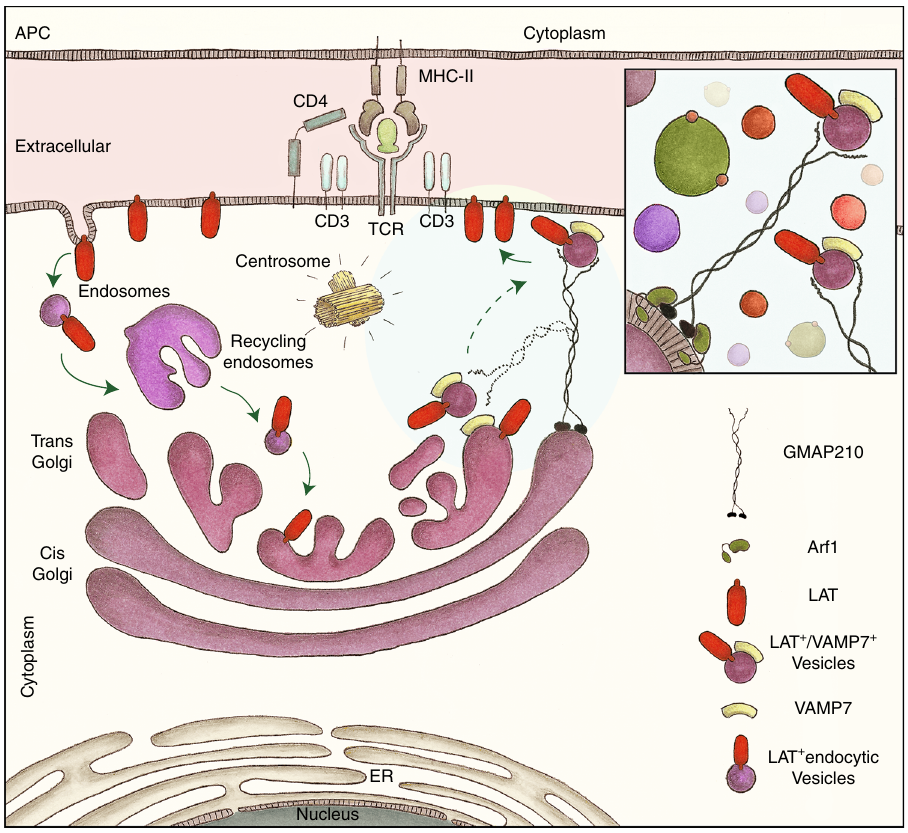
Fig. 9 Graphical abstract: GMAP210 facilitates the delivery of vesicles containing LAT to the immune synapse. Upon TCR triggering, LAT is internalized in recycling endosomes. This endocytic pool of LAT is “ retrotransported ” to the Golgi apparatus 24 , where it meets the vesicular SNARE VAMP7 that is involved in LAT traf fi cking 13 . GMAP210, which binds the Golgi through Arf1, sorts and captures the LAT/VAMP7 vesicles via its N-terminal domain (inset). The long coiled-coil domain of GMAP210 then brings LAT-containing vesicles close to the immune